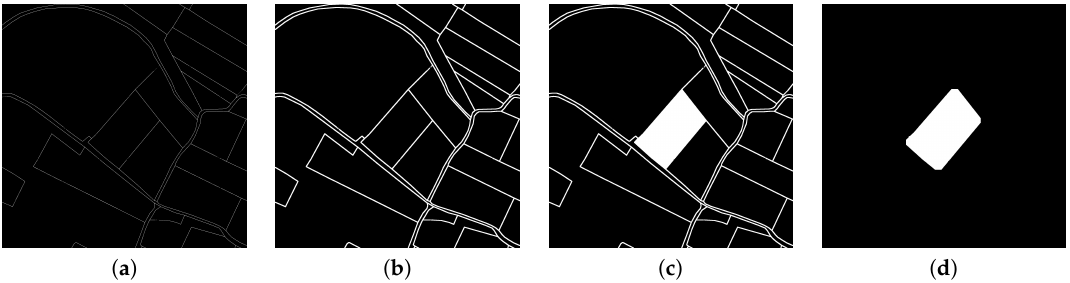
Figure 4. Filtering the parcel images to detect the parcel or grove where the robots are located. ( a ) after applying the custom binarization, ( b ) after dilating, ( c ) after filling the current parcel, ( d ) after